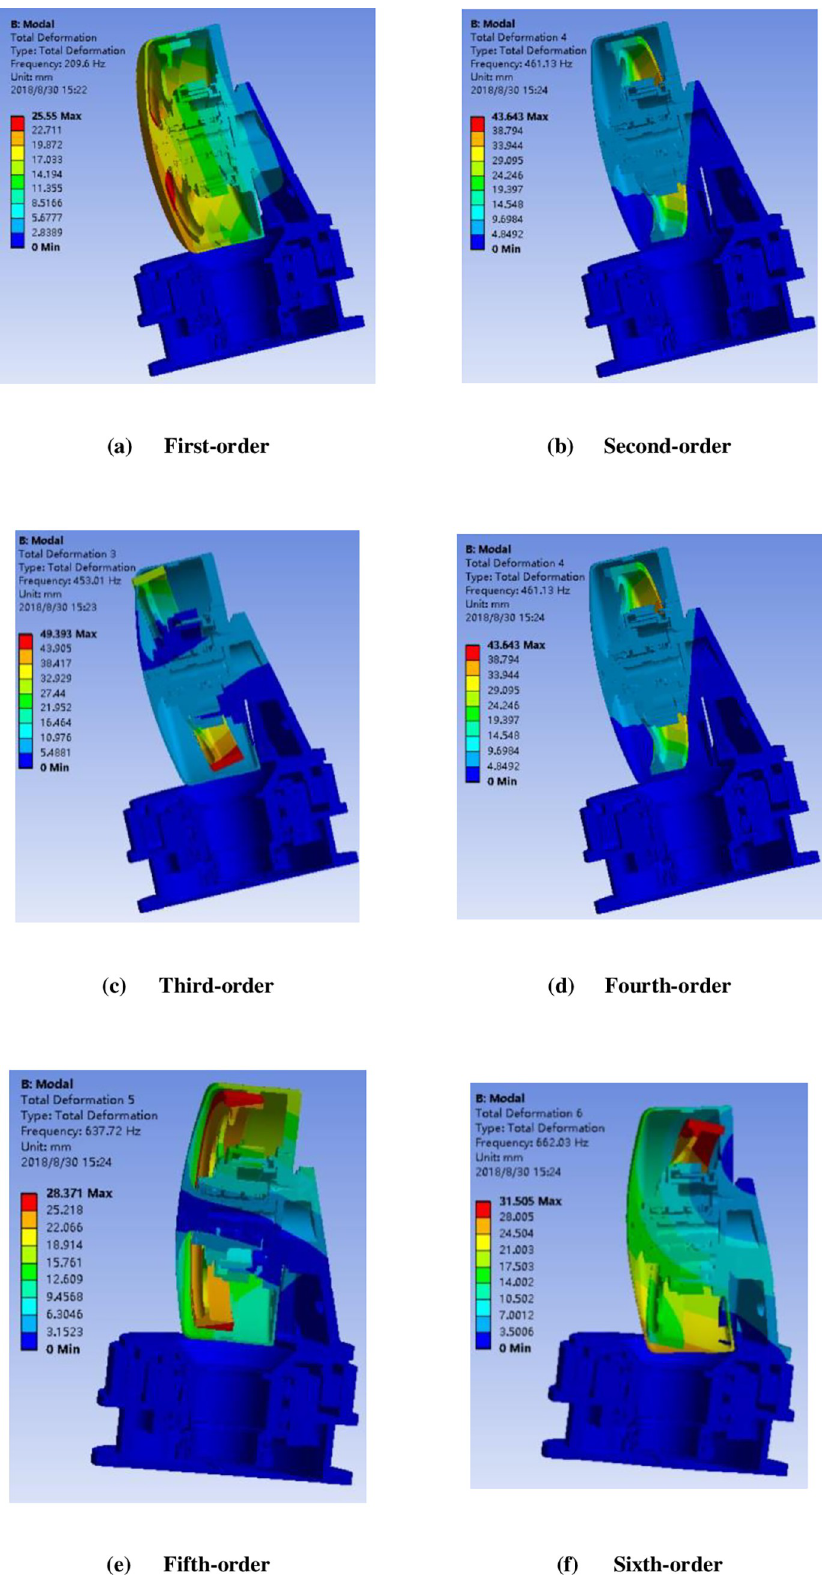
Fig 6. Frequency nephogram of each